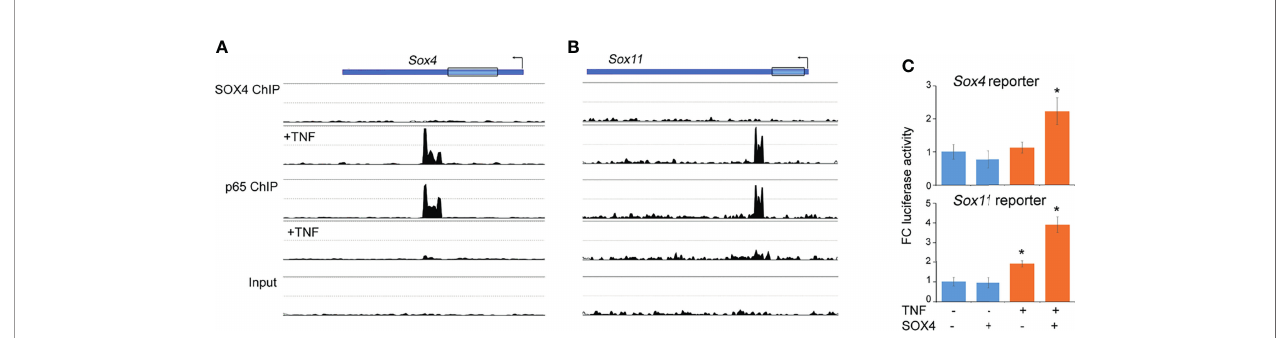
FIGURE 3 | Autoregulatory switch in the Sox4 and Sox11 gene expression. (A, B) Changes in the pro fi les of SOX4 and RELA ChIP-seq peaks in the Sox4 and Sox11 genomic locus upon TNF treatment. (C) Fold-change Sox4 and Sox11 luciferase reporter activity in HEK293 cells transfected with SOX4 expression plasmids and treated with 10ng/mL TNF for 16h. *p-value < 0.05 by student ’ s t-test compared to